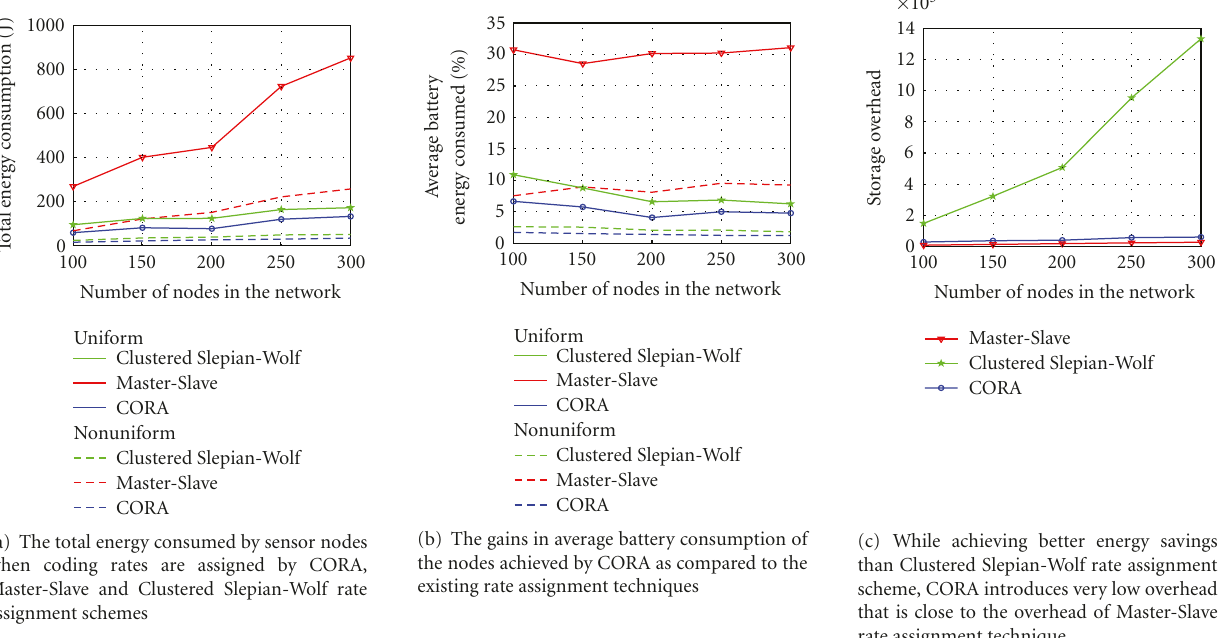
Figure 10: Performance evaluation of CORA with respect to existing rate assignment